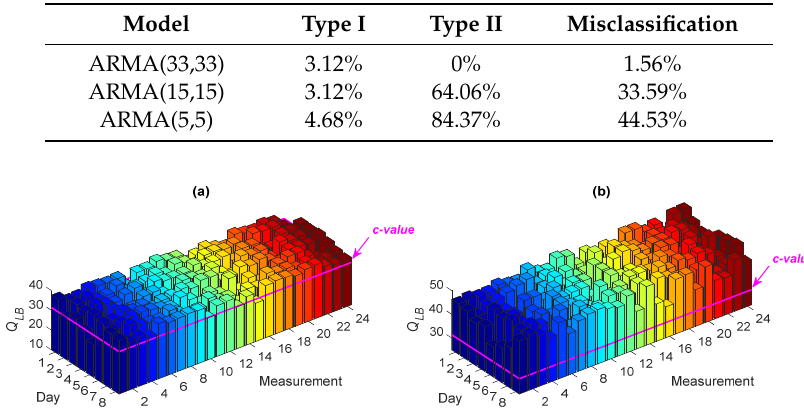
Figure 9. LQB test statistics for ( a ) ARMA(15,15) and ( b ) ARMA(5,5) to model the vibration responses at Sensor 8 for all test measurements on Days 1–8.